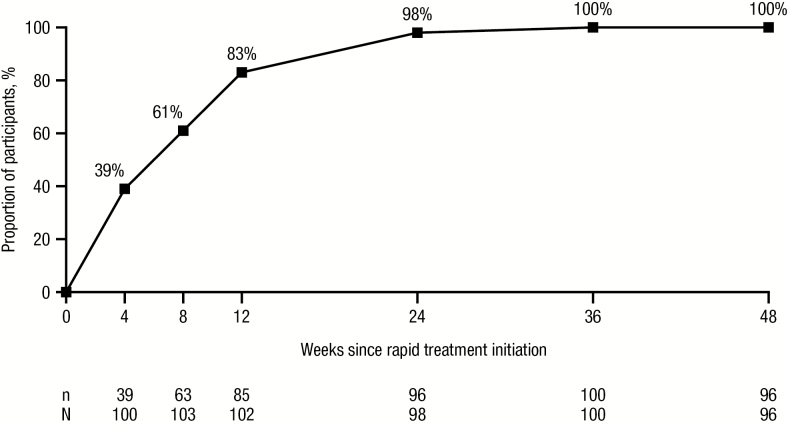
Virologic response over time since darunavir/cobicistat/emtricitabine/tenofovir alafenamide rapid initiation (human immunodeficiency virus type 1 RNA <200 copies/mL; observed analysis).